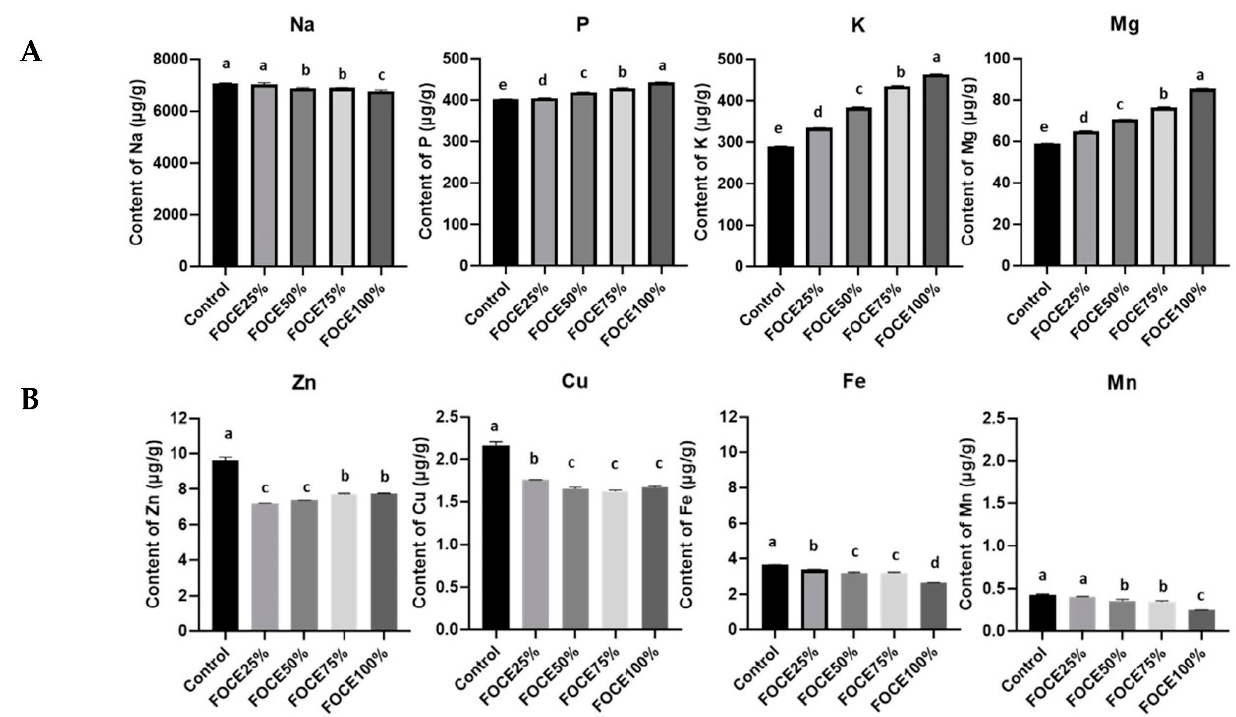
Figure 2. The minerals content in experimental gluten-free breads with FOCE: ( A ) macroelements ( µ g/g); ( B ) microelements ( µ g/g). Values with the same letter do not differ significantly ( p < 0.05) when subjected to the one-way analysis of variance (ANOVA) with Tukey’s multiple comparison test.